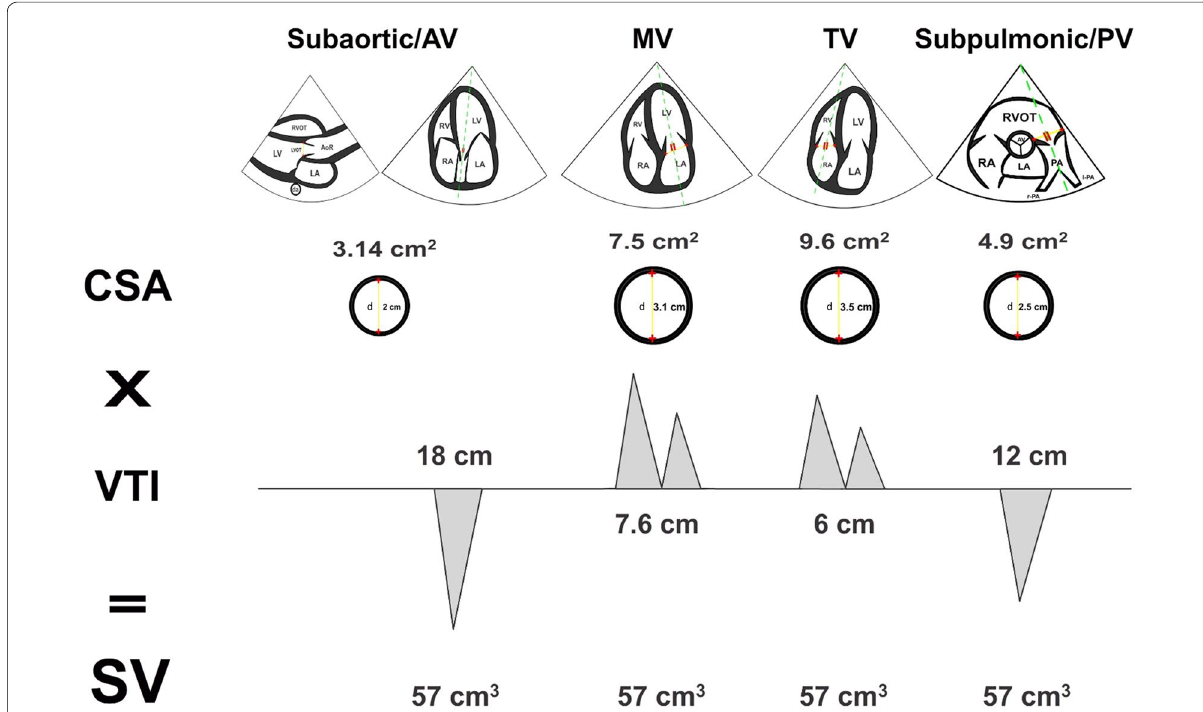
Fig. 3 Principle of mass conservation. In the absence of valvular regurgitation or intracardiac shunts, the stroke volume (SV) is the same across each valve or orifice. CSA: cross-sectional area; VTI: velocity–time integral; AV: aortic valve; MV: mitral valve; TV: tricuspid valve; PV: pulmonary valve; LVOT: left ventricular outflow tract; d: diameter; CSA: cross-sectional area; VTI: velocity–time integral; HR: heart rate; RVOT: right ventricular outflow tract; LV: left ventricle; AoR: aortic root; LA: left atrium; da: descending aorta; RA: right atrium; RV: right ventricle; PA: pulmonary artery; r-PA: right-PA; l-PA: left-PA